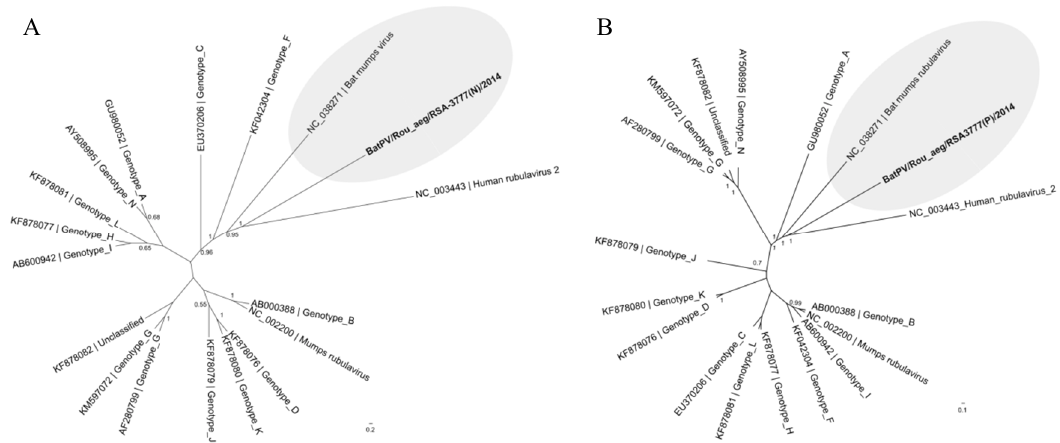
Figure A1. Bayesian phylogenetic analysis of two partial gene regions of a putative bat mumps rubulavirus with representatives of known mumps genotypes. ( A ) Partial nucleoprotein ( N )